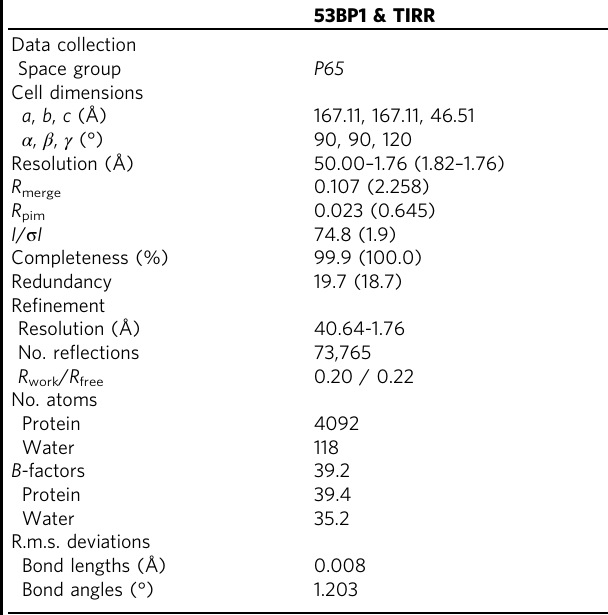
Fig. 1 Characterization of the TIRR/53BP1 Tudor complex. a Schematic presentation of 53BP1 and TIRR prepared using IBS software 30 . The 53BP1 N- terminal region containing 28 × S/TQ sites, the 53BP1 Tudor domain, UDR domain, and TIRR are either labeled or colored in magenta, orange, and cyan, respectively. The secondary structure of 53BP1 double Tudor and TIRR are presented, with the interaction regions of Tudor and TIRR highlighted at the bottom. b Isothermal titration calorimetric analysis of TIRR binding to 53BP1 Tudor or Tudor-UDR. TIRR is titrated by 53BP1 Tudor (left) and 53BP1 Tudor- UDR (right). c Sedimentation coef fi cients for 53BP1 Tudor (magenta) and TIRR (cyan), and the complex formed by 53BP1 Tudor and TIRR in 2:2 ratio (black). The sedimentation coef fi cient distributions c(s) are plotted in relative absorbance units A 280 vs. svedbergs (S). d The overall structure of TIRR in complex with the 53BP1 Tudor domain. TIRR protomers are shown by cyan and green, respectively. The 53BP1 tandem Tudor domain is colored in magenta. The N-terminal region and L8-loop of TIRRs (in Tudor-bound or unbound forms), along with the L1, L3, L1 ′ loops of 53BP1 Tudor are